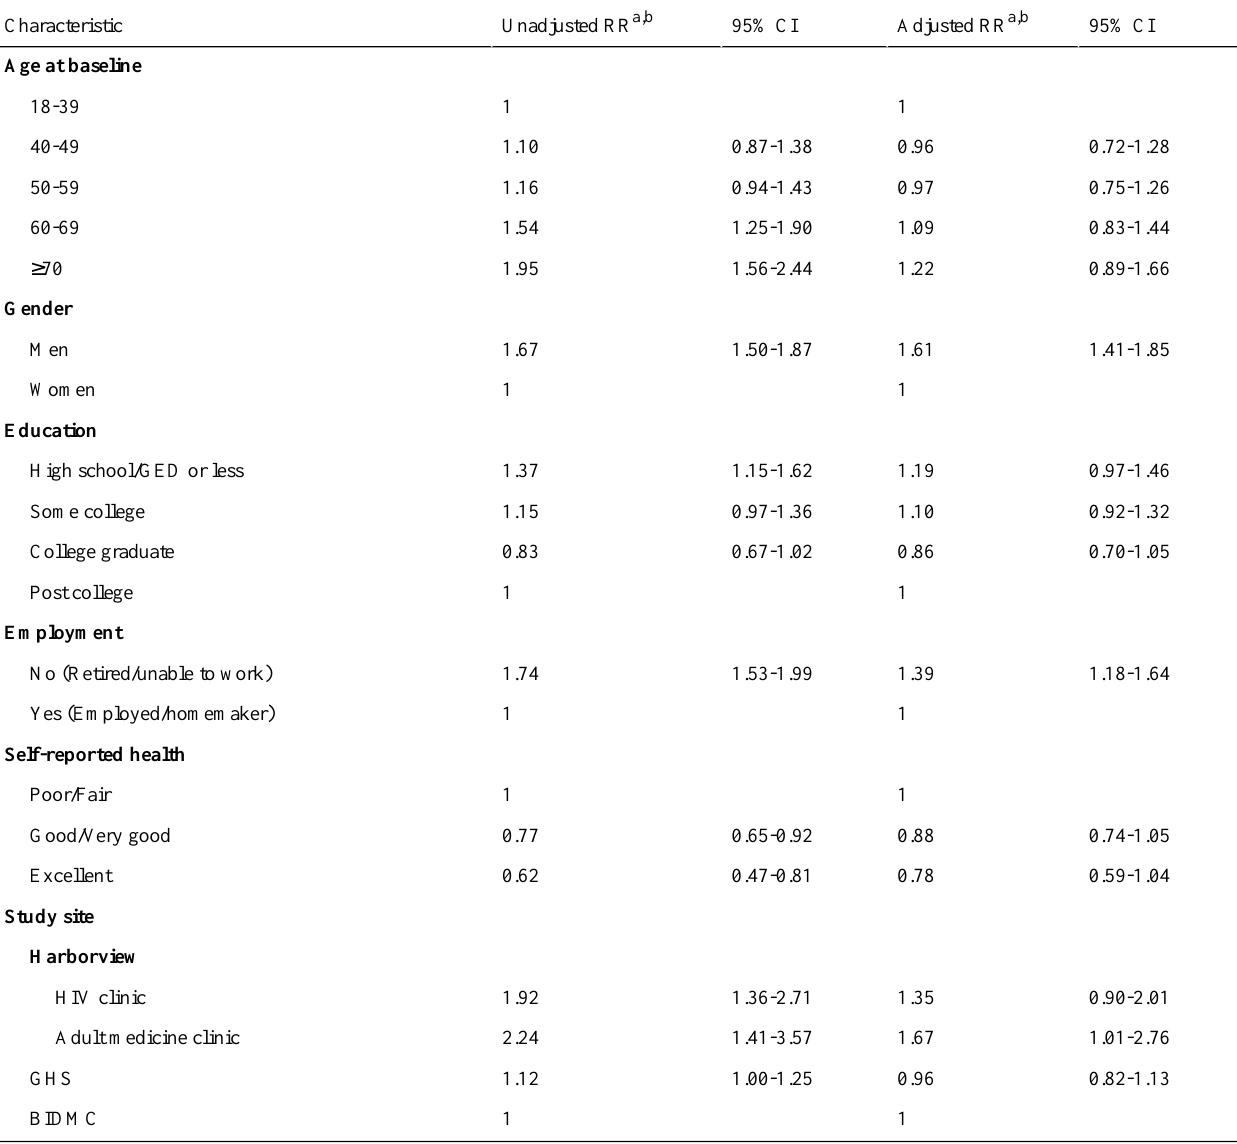
Table 4. Unadjusted and adjusted association between patients who shared visit notes and demographic characteristics, self-reported health, and study site.